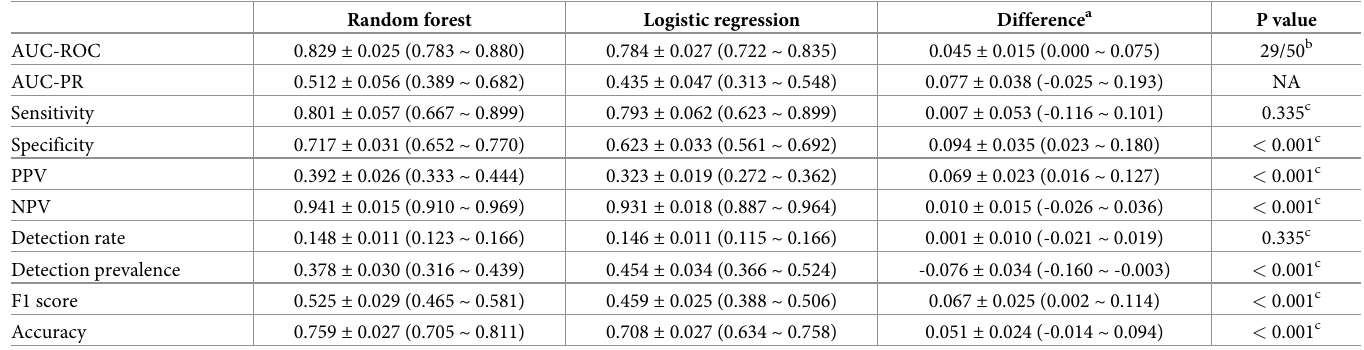
Table 2. The predictive performance between the RF and LR models. Random